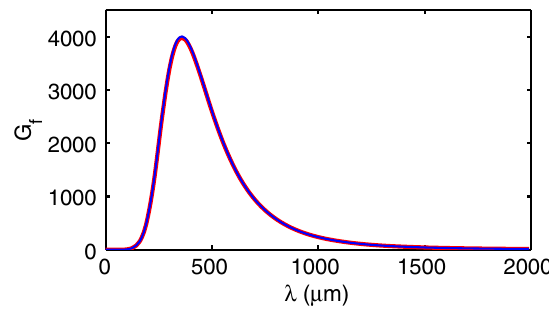
FIG. 3. CSR gain spectra as a function of initial modulation wavelengths for the JLEIC CCR lattice. G f is evaluated as one- turn microbunching gain. The red curve is obtained by the formulation developed in this paper, while the blue curve is from our previously developed semianalytical Vlasov solver [43] for nonmagnetized beams.